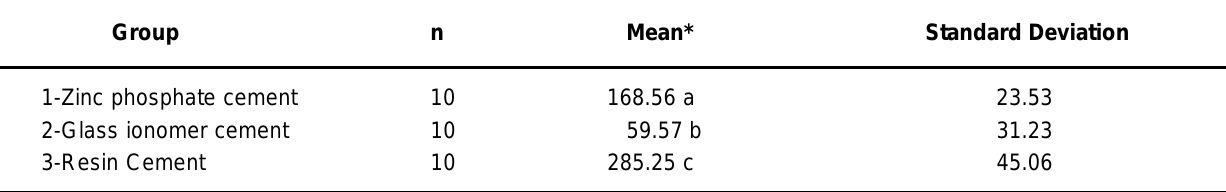
TABLE 1- Mean times and standard deviations, in seconds, required for post